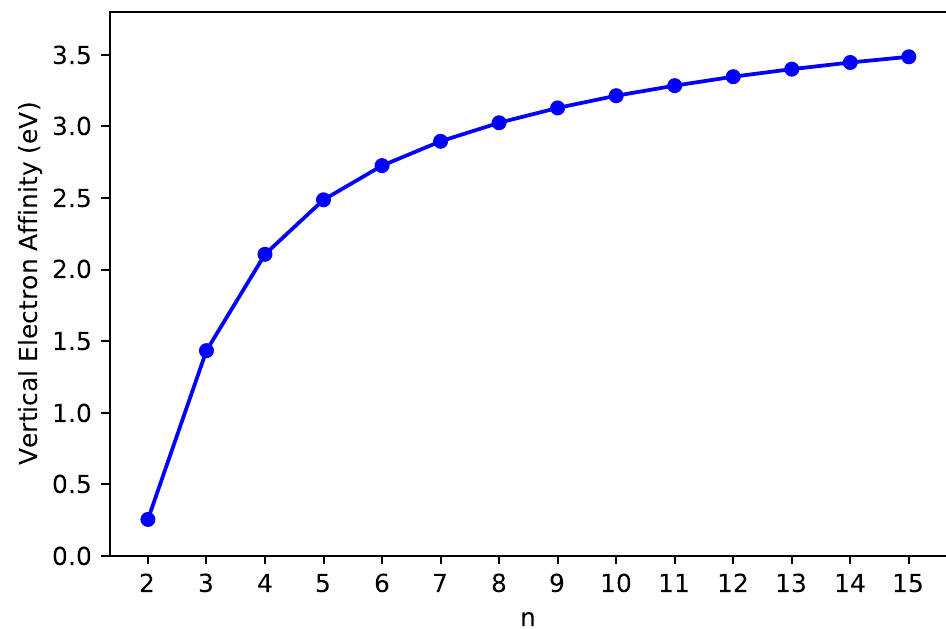
Figure 4. Vertical electron affinity of ground-state n -pyrene, calculated by spin-unrestricted TAO-LDA.